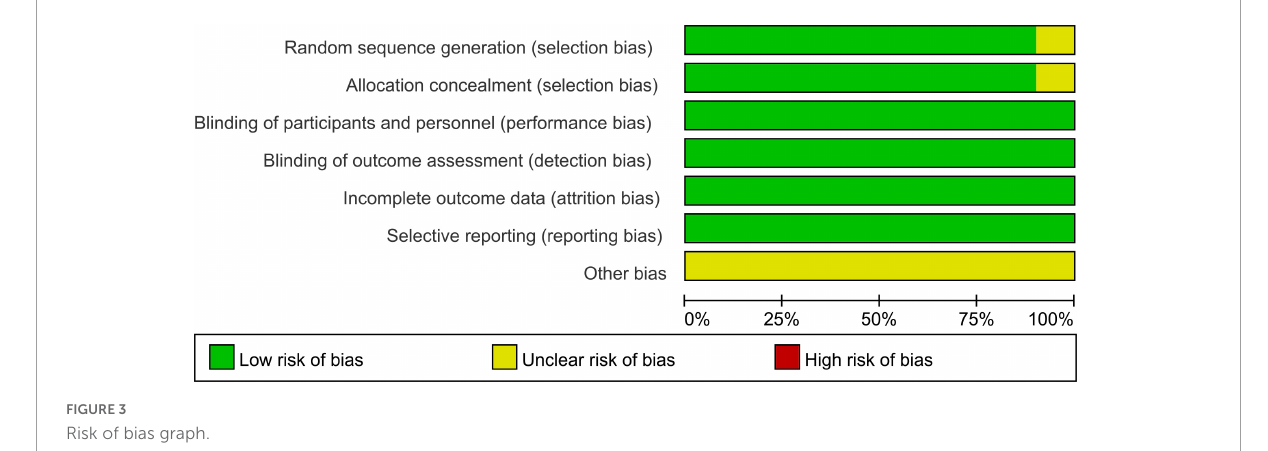
FIGURE3 Risk of bias graph.